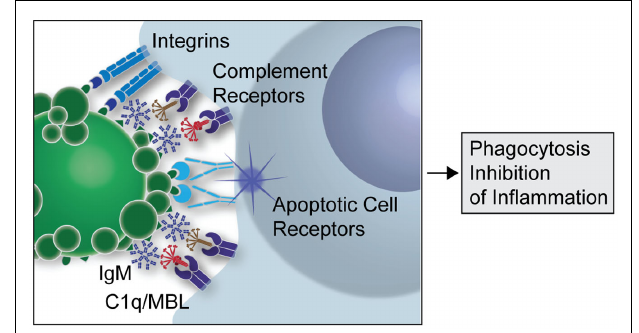
FIGURE 1 | Postulated contribution of natural IgM in apoptotic cell clearance. Schematic overview of how natural IgM binding to apoptotic cells may facilitate the formation of an apoptotic synapse between the apoptotic cell or microparticle and the phagocyte, and this leads to enhanced recruitment of the complement recognition factors, C1q and MBL. A large number of other ligands and receptors have been suggested to promote phagocytosis of apoptotic cells, which are not shown in this simplified